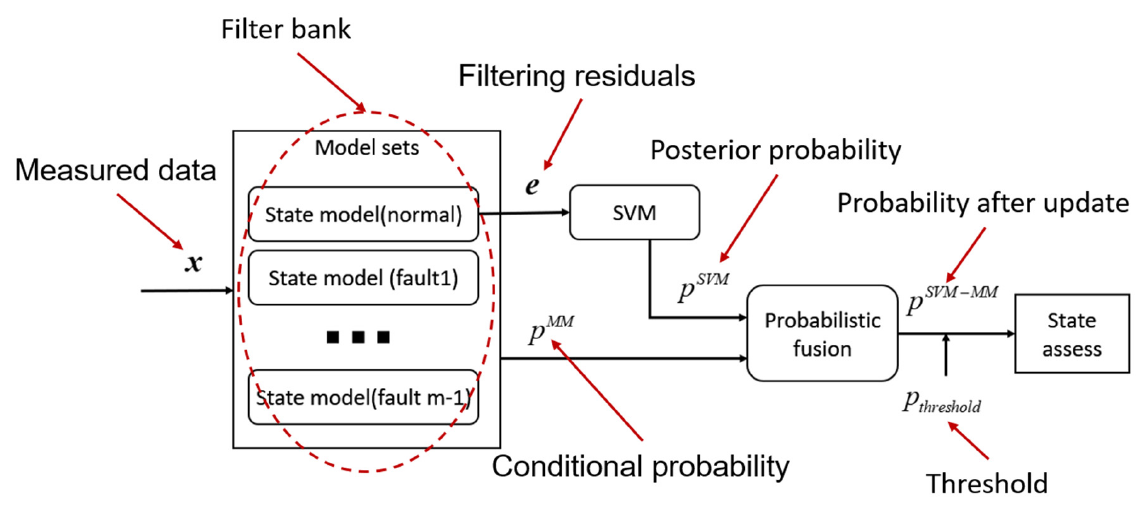
Figure 1. Architecture of the SVM-MM.